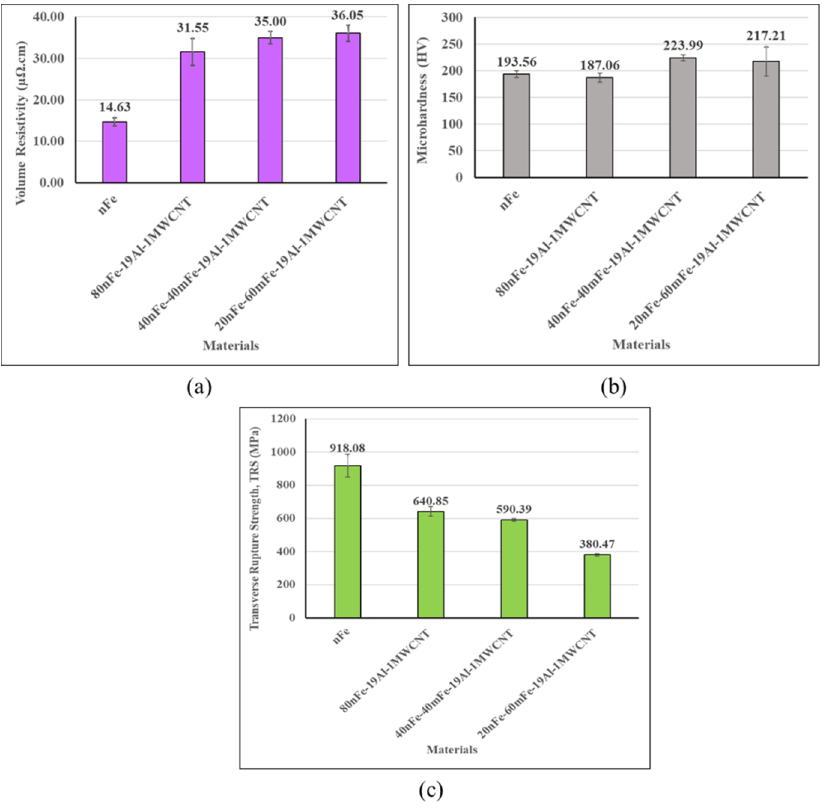
Figure 15. Effect of Fe nanoparticles and Fe microparticles mixture on: ( a ) electrical resistivity; ( b ) Vickers microhardness and ( c ) transverse rupture strength.